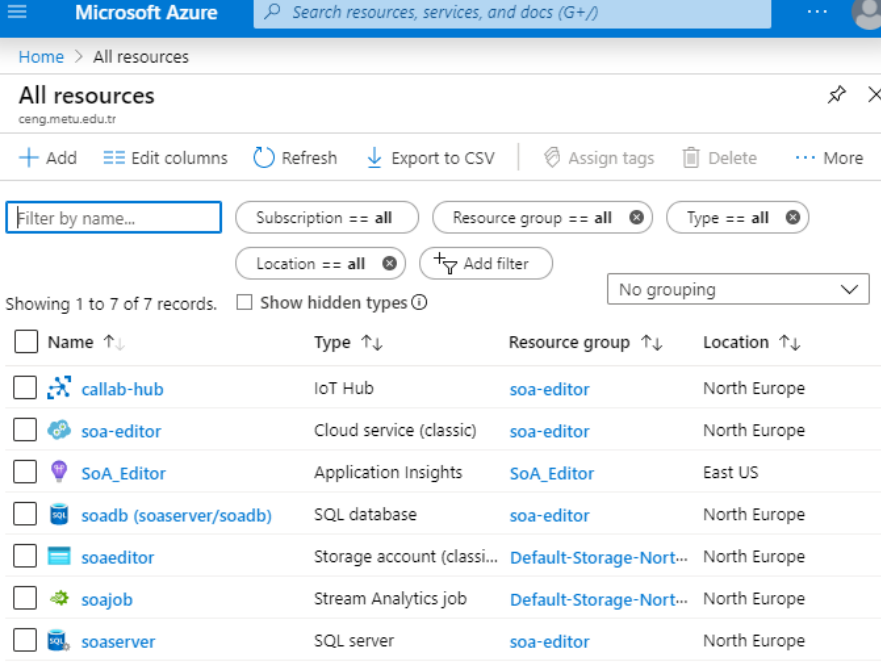
Figure 11. Allocated resources and services on the Azure